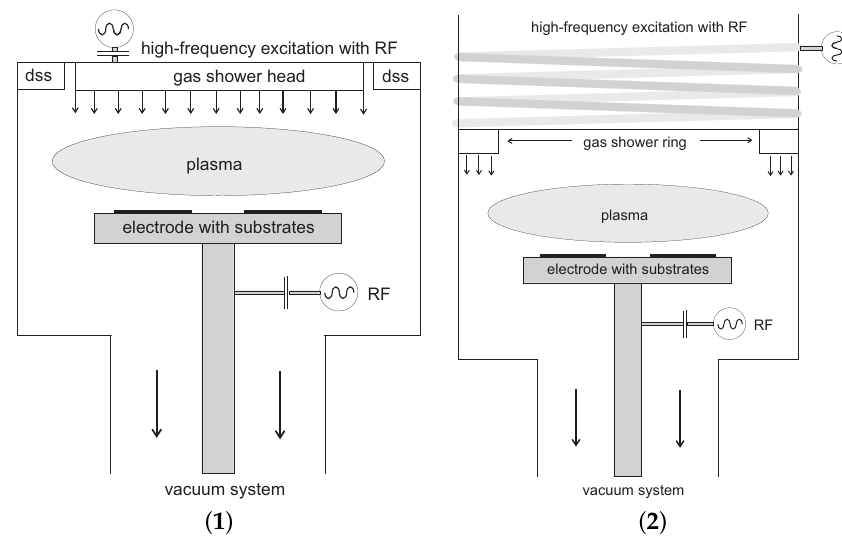
Figure 3. PECVD reactors. ( 1 ): parallel-plate reactor with inverted power configuration. The substrate is placed upon the “cold” electrode, which is normally grounded. The capacitive coupling offers the possibility of substrate biasing for stress control. ( 2 ): ICP reactor with capacitively-coupled bottom electrode. Operating frequencies for plasma generation are 13.56/27.12 MHz; for bias, 2 or 13.56 MHz are customary, sometimes frequencies in the high kHz range. “dss” denotes the dark space shield which suppresses sputtering of the shower head. A conventional parallel-plate reactor for PECVD is evacuated by a one stage pump system which reaches a vacuum of 1 mTorr, whereas an ICP reactor is always evacuated by a double pump system (in most cases the second stage is a turbopump), and the base vacuum is better than 10 − 5 Torr (<1